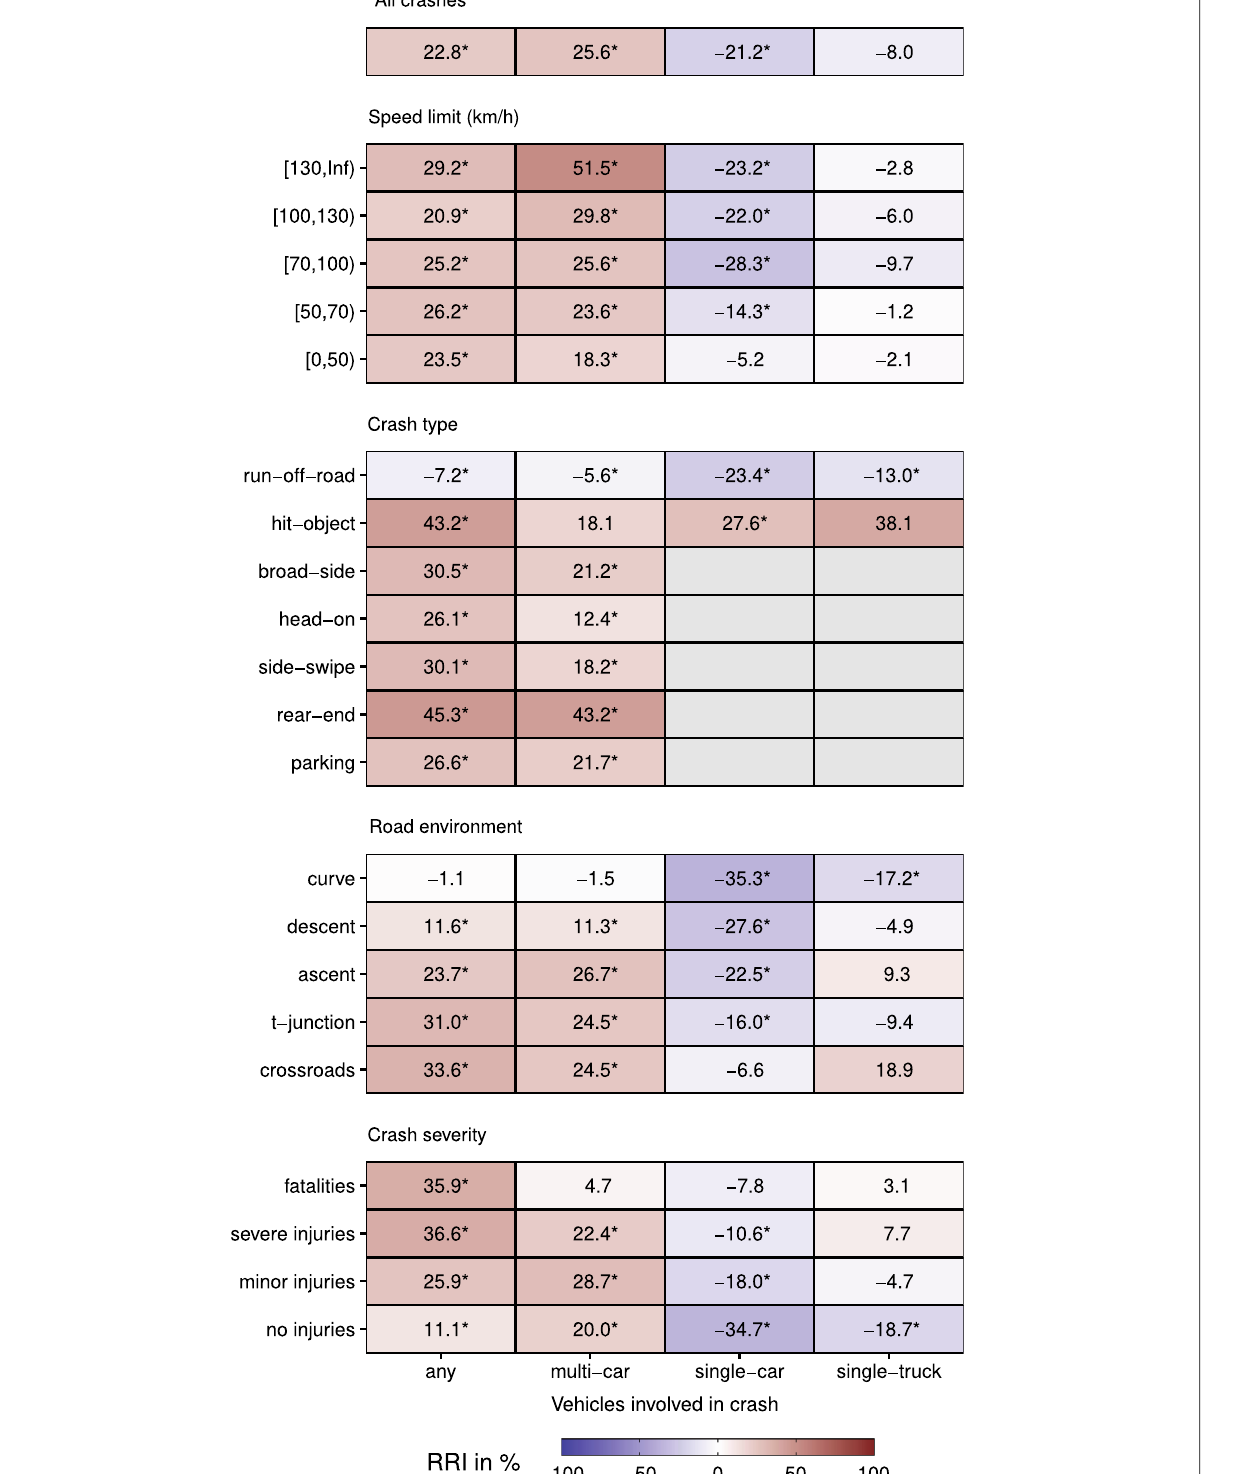
Fig. 5 Relative risk increase (RRI) of crash probabilities in situations with low sun elevation angle and cloud free conditions ( Elv = 20 ◦ and Cld = 0 %) compared to situations with low sun elevation angle and clouded conditions ( Elv = 20 ◦ and Cld = 100 %). Significant changes (i. e. more than 95 of 100 models fitted with randomly drawn training data show the same direction of change) are indicated with an